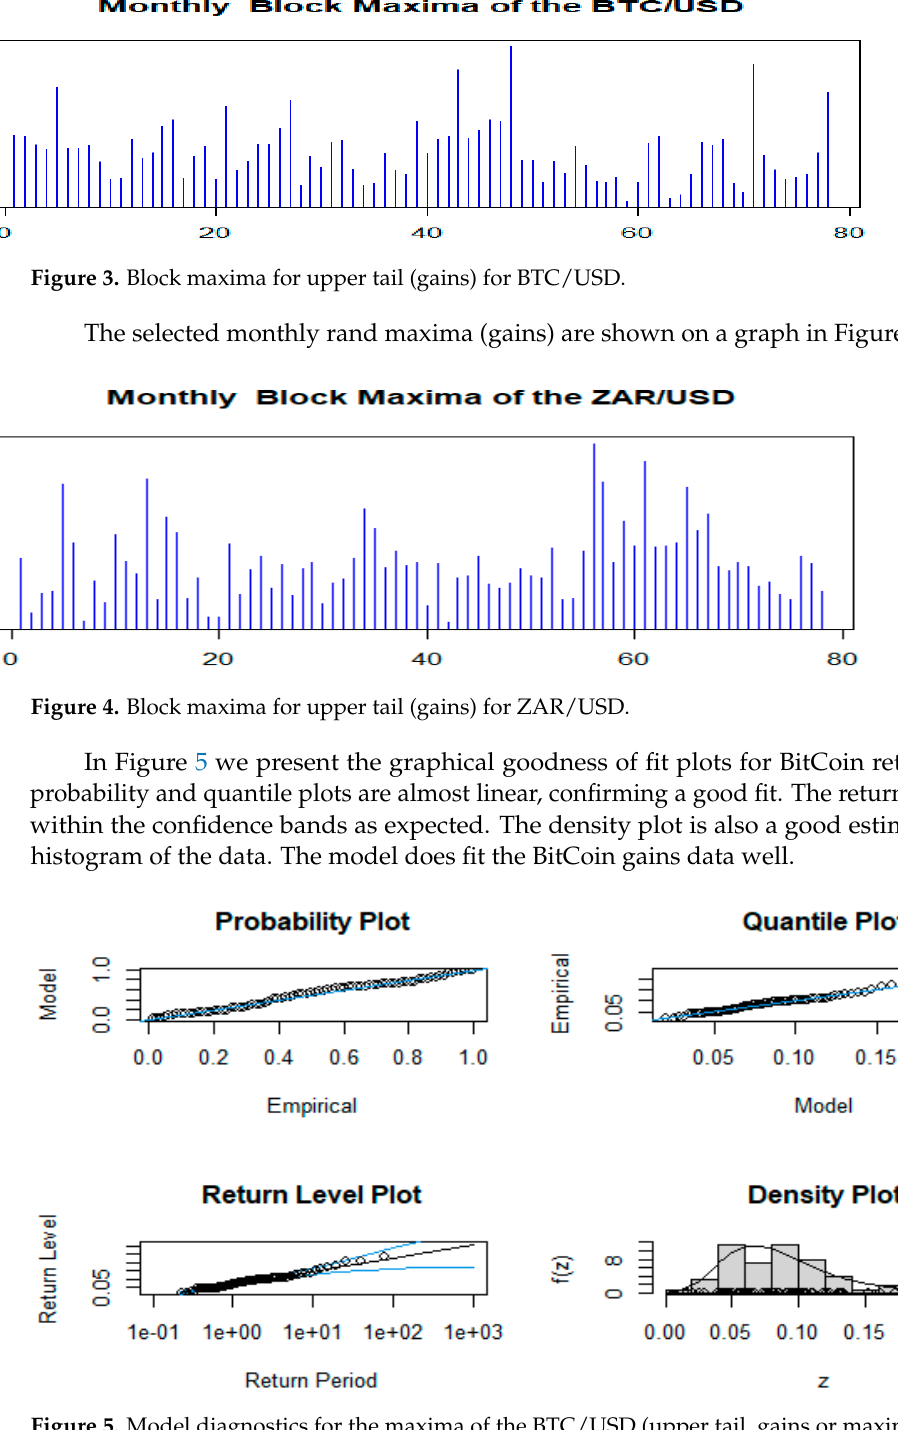
Figure 6. Model diagnostics for the maxima of the ZAR/USD (upper tail, gains or maxima returns). 4.2. Analysing Losses for the BTC/USD and ZAR/USD To obtain to the losses, the data are transformed using the formula 𝑙 (cid:3047) = −1 ∗ 𝑦 (cid:3047) . Monthly maxima are again selected from these losses to come up with a new set of loss- es, much smaller in quantity/size, of the data set. The selected monthly BitCoin maxima losses are depicted in Figure 7.